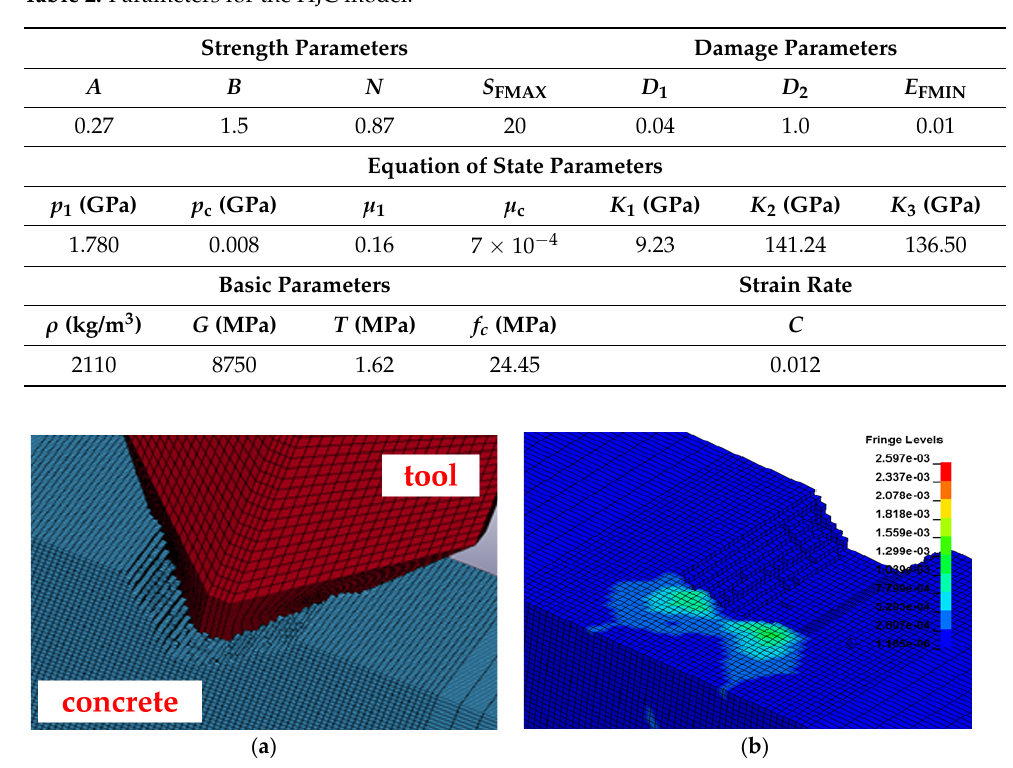
Figure 6. The 3D numerical model of cutting concrete: ( a ) Diagram of model; ( b ) Equivalent stress diagram of the concrete.